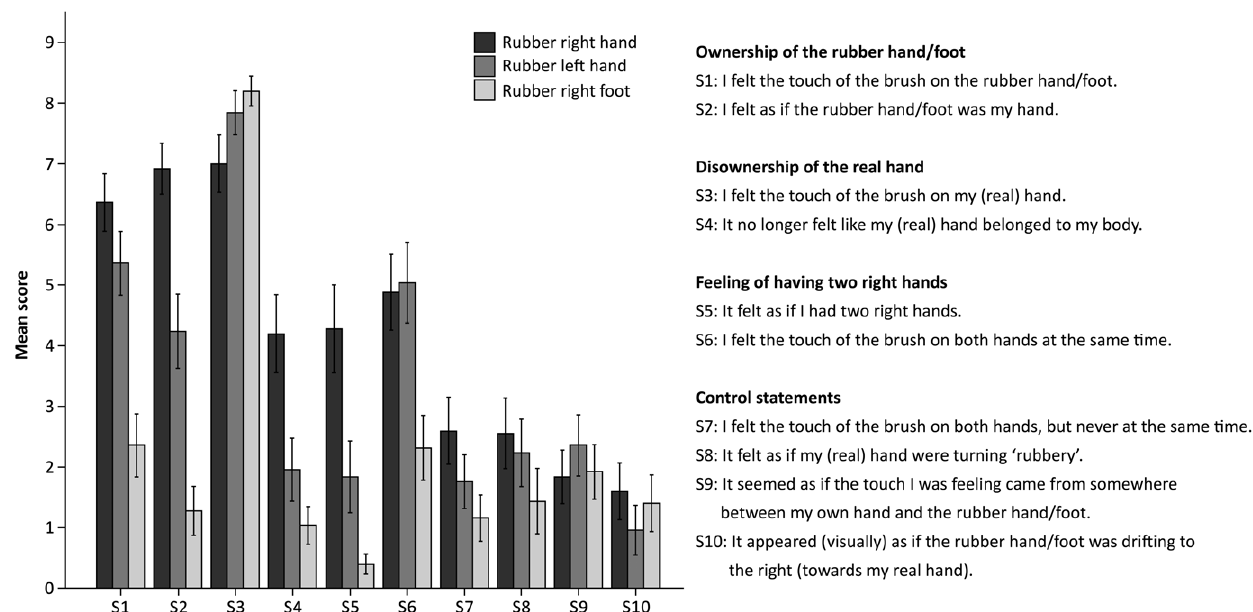
Figure 6. Introspective evidence for what type of limb that can be owned as a supernumerary limb. Questionnaire data from experiment 3 where synchronous brushing was applied on the real right hand and a rubber right hand (the illusion condition), a rubber left hand or a rubber right foot (the control conditions). During the illusion, we observed significantly stronger rubber hand ownership (S1–S2) compared to the rubber left hand (p=0.007) and rubber right foot conditions (p , 0.001), respectively; significantly stronger real hand disownership (S3–S4) than for both the rubber left hand (p , 0.001) and the rubber right foot conditions (p , 0.001); and a significantly stronger feeling of having two right hands (S5–S6) compared to the rubber right foot condition (p , 0.001). This implies that participants only experience ownership of a supernumerary rubber hand when it resembles the real hand in respect to laterality (i.e. right-left matching) and limb type (i.e. both hands, but not a hand and a foot). The error bars represent the standard error.